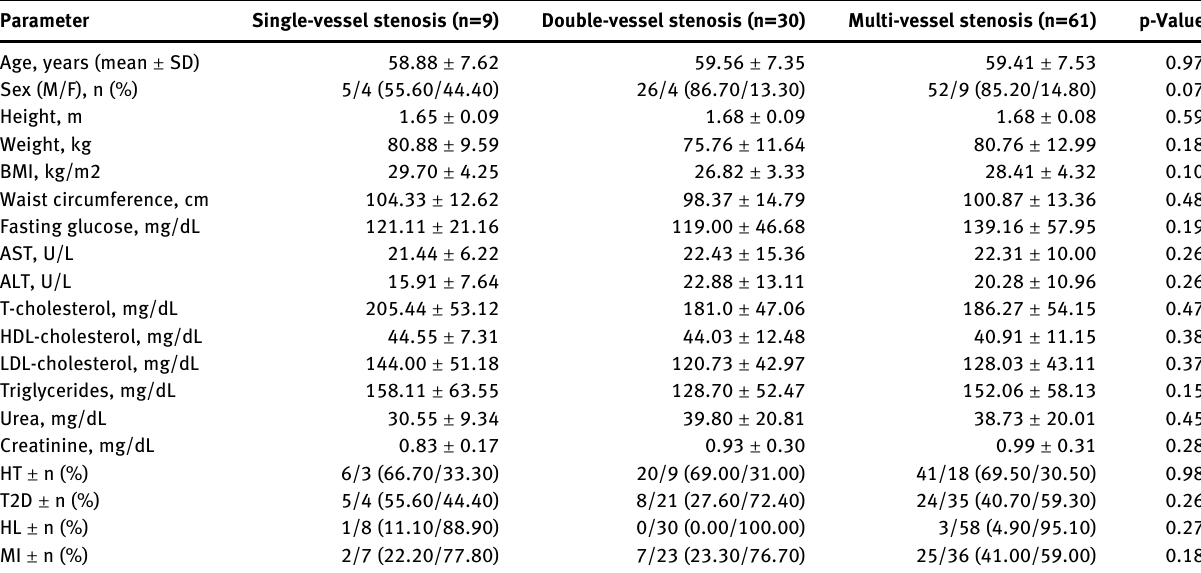
Table  : Comparisonoftheseverityofvesselstenosisintermsofdemographicandclinicalcharacteristicsofcoronaryarterydiseasepatients. Parameter Single-vessel stenosis (n=  ) Double-vessel stenosis (n= 